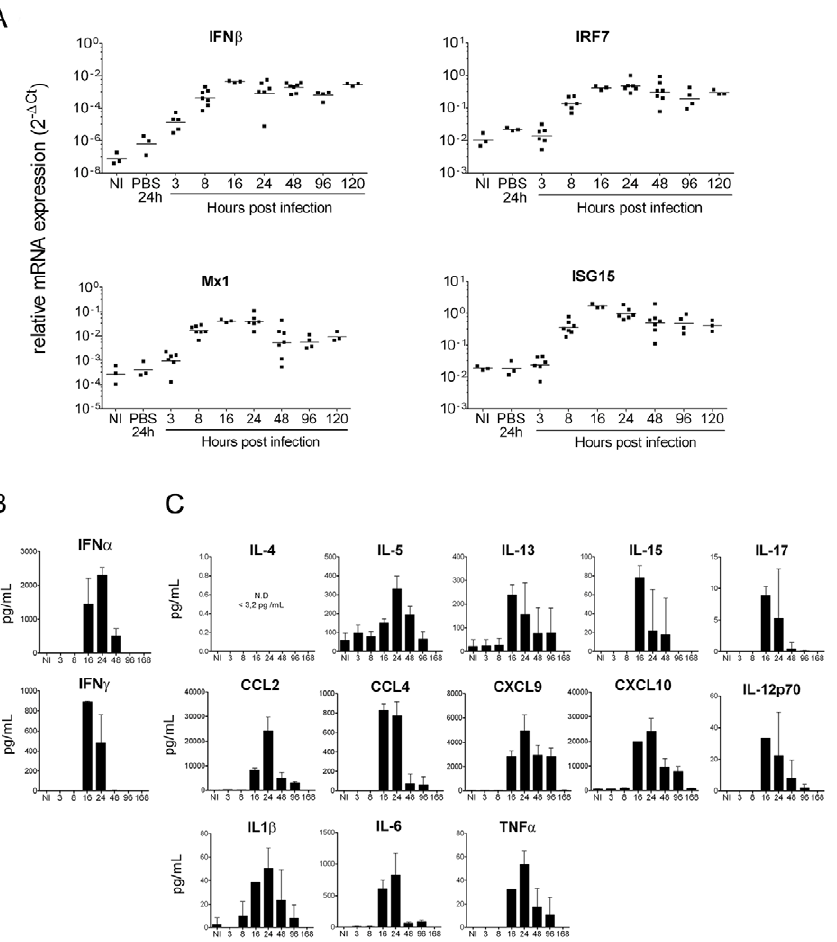
Figure 3. Neonatal mice mount a robust IFN and pro-inflammatory cytokine/chemokine response following CHIKV infection. Nine day old C57BL/6 mice were injected s.c. in the right flank with CHIKV. ( A ) The skin at the site of infection was harvested at the indicated times post infection and IFN b , IRF7, Mx1 and ISG15 gene expression was evaluated by qRT-PCR. The D Ct was calculated using GAPD as a reference gene. At various time points, sera was harvested and tested for ( B ) IFN a by ELISA and IFN c using Luminex. ( C ) Serum cytokines and chemokines were also analyzed using Luminex. Each graph represents 2–3 independent experiments with 3 mice per experiment.